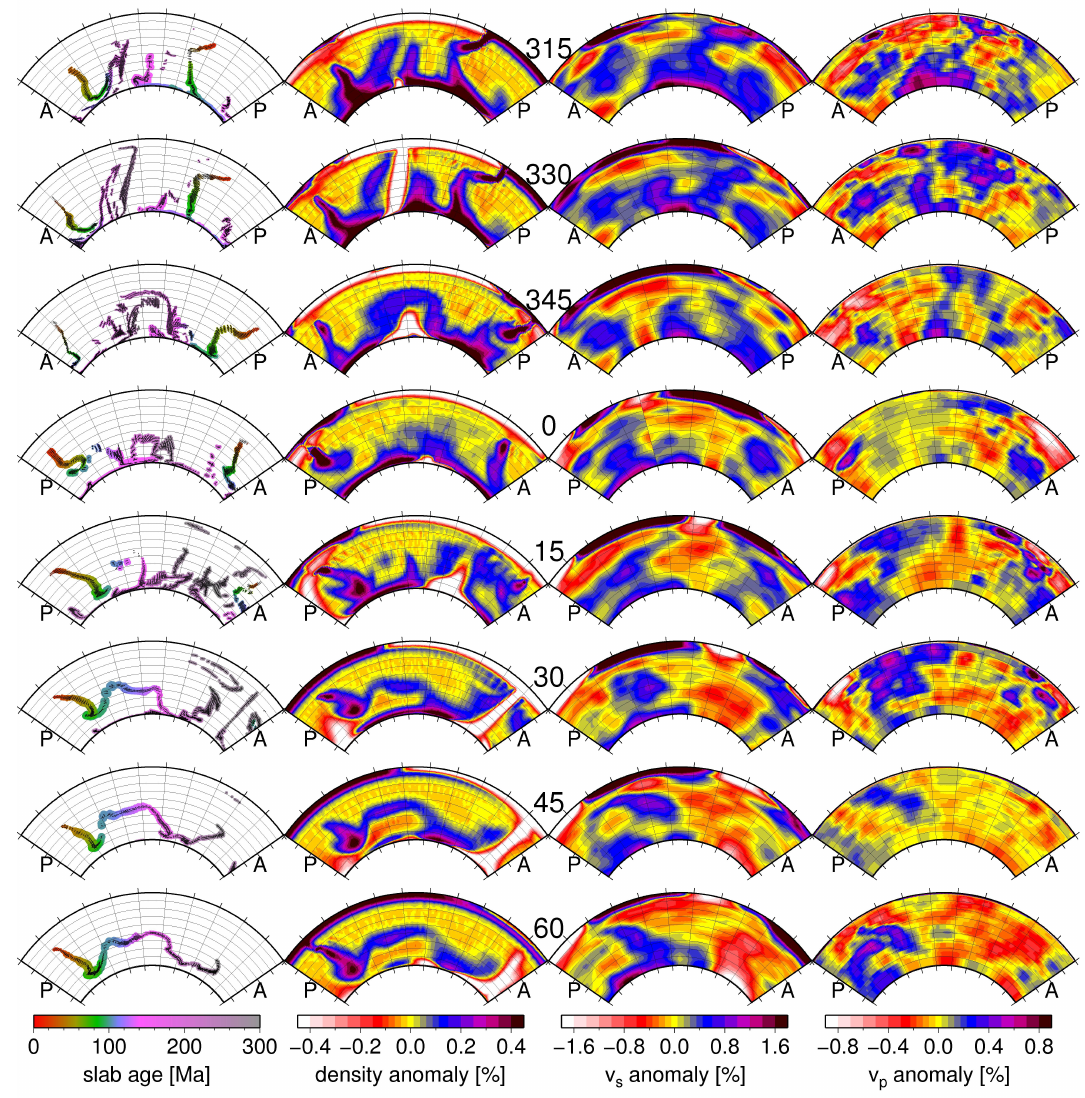
Fig. 6a. Part (B) : Cross sections beneath Northern Asia (top panels) and North America (bottom